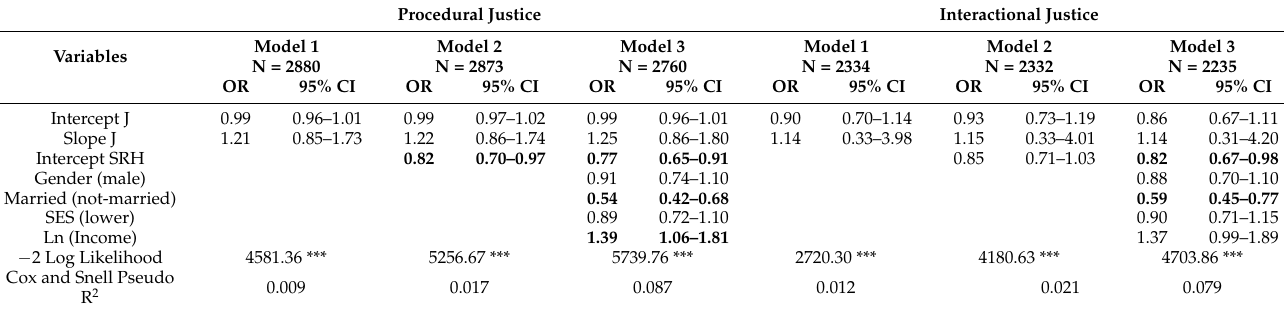
Table 6. ORs for early retirement as compared to normative retirement (reference group) for procedural justice and interactional